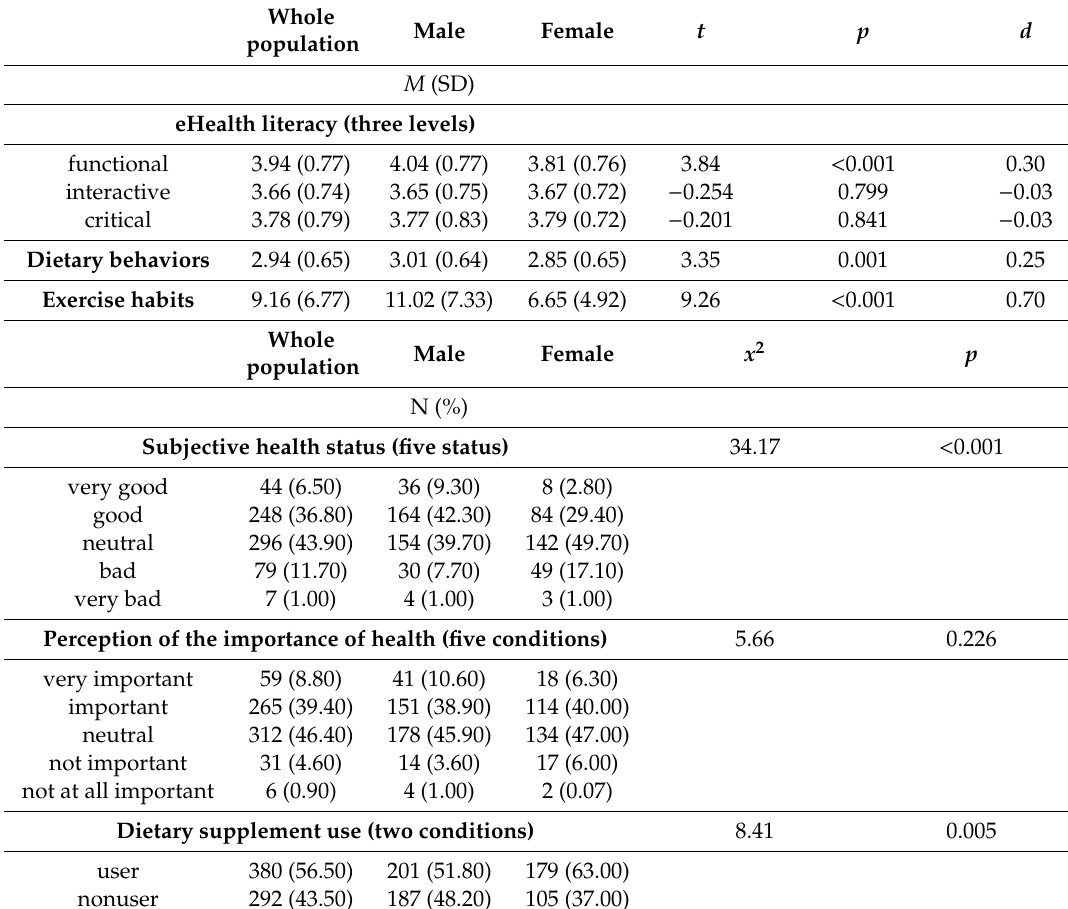
Table 1. Descriptive statistics and t -test results for our